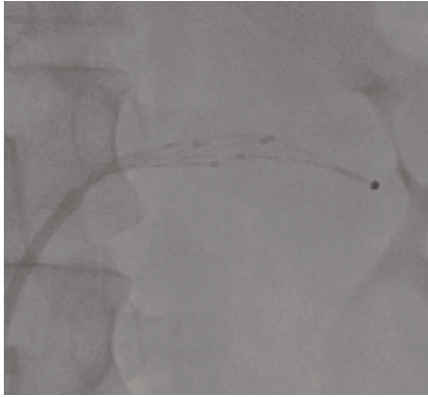
Figure 1: Angiographic image of the renal denervation catheter applying circumferential